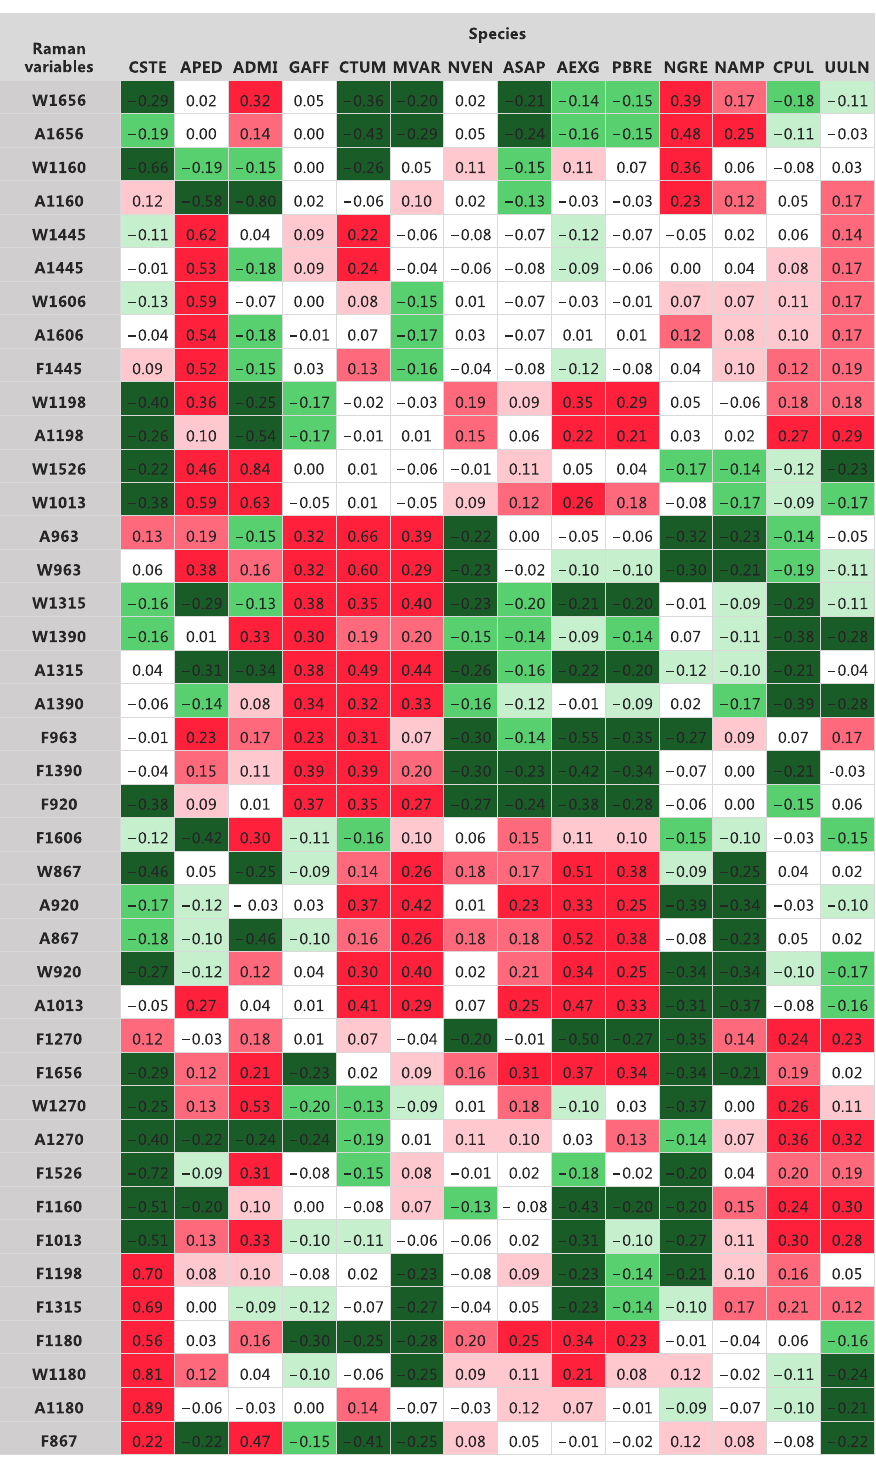
Figure 4. Relationship (covariation) between each Raman variable and each of the best characterised species derived from the integrated analysis (scalar projections) of the six PLS-DA components. Raman variables are represented as width (W), area (A), and frequency (F) of the spectral bands. The colour code indicates the global percentile category of the scalar projections in the whole set. Categories are as follows: dark green, 0–5%; green, 5–10%; light green, 10–20%; pink, 80–90%; red, 90–95%; dark red, 95–100%. The darker the red (positive) or green (negative) tone the greater the effect of the Raman variables over the species. Species legend as in Figure